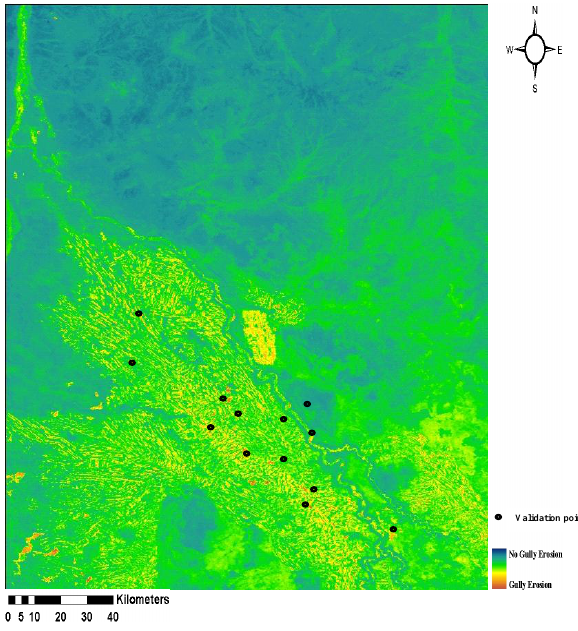
Figure 7 Regional spatial distribution map of seasonal gullies of the Blue Nile, Eastern